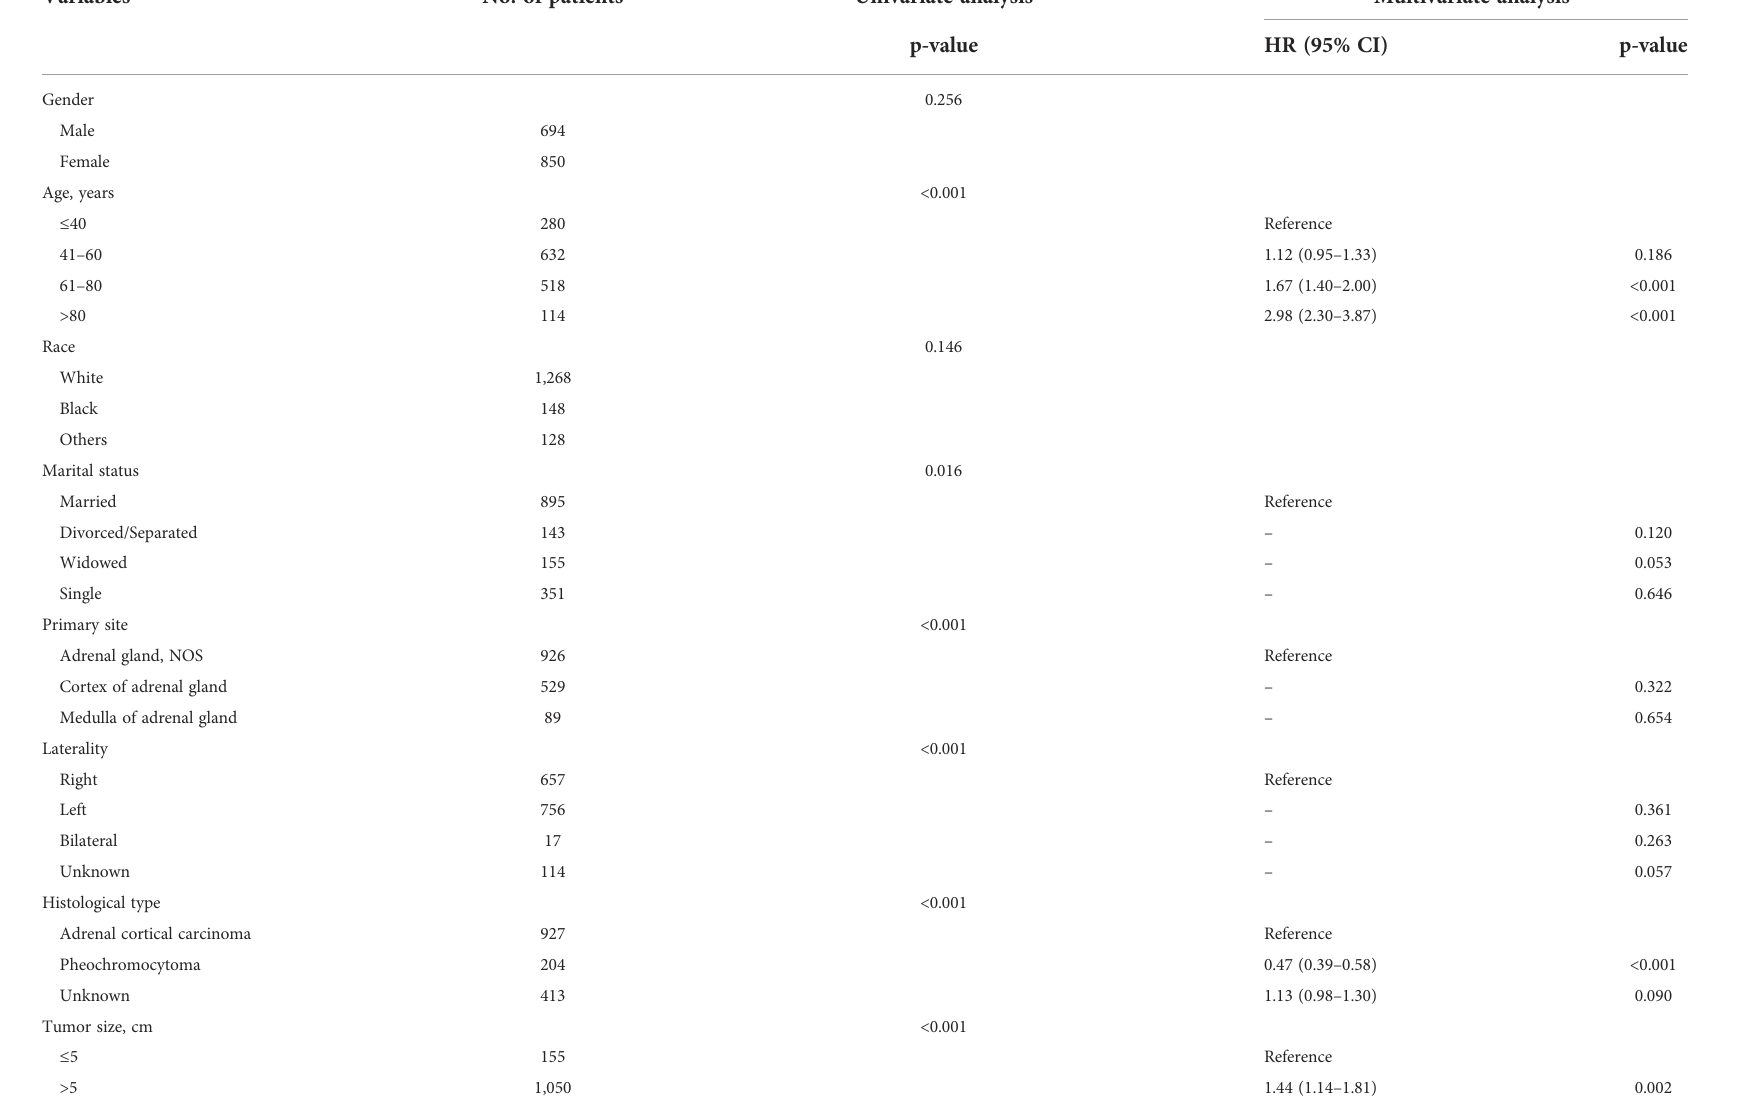
TABLE 3 Univariate and multivariate analysis of cancer-speci fi c survival (CSS) rates in the training